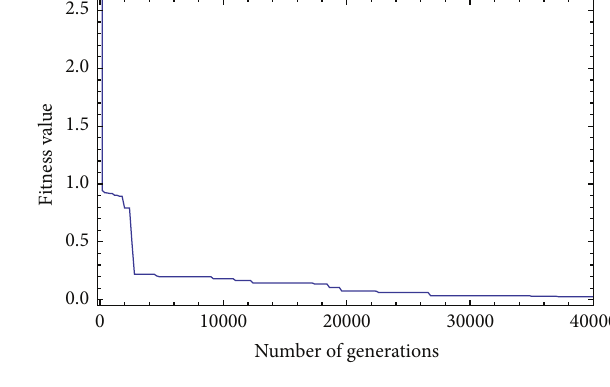
Figure 19: Performance graph for Case 9.